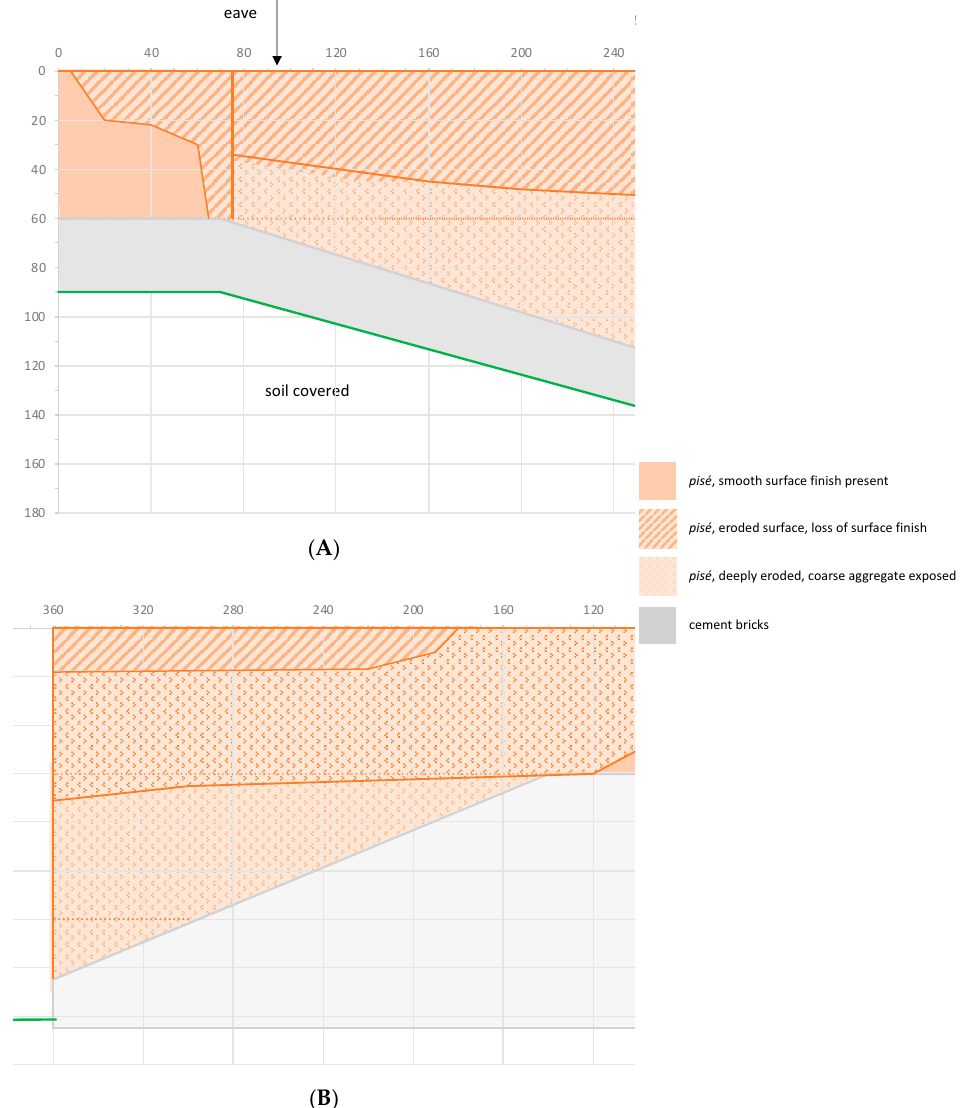
Figure 13. Schematic representation of the observed decay of wall 1: ( A ) eastern face; ( B ) western face.